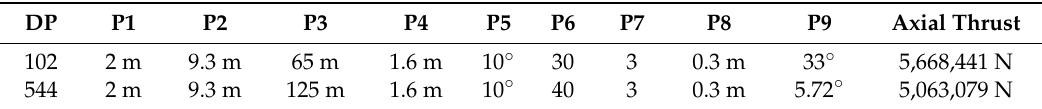
Table 7. SERN geometries which yield maximum thrust at 30 m and 40 m expansion ramp length for BCC 3.2. BCC DP P1 P2 P3